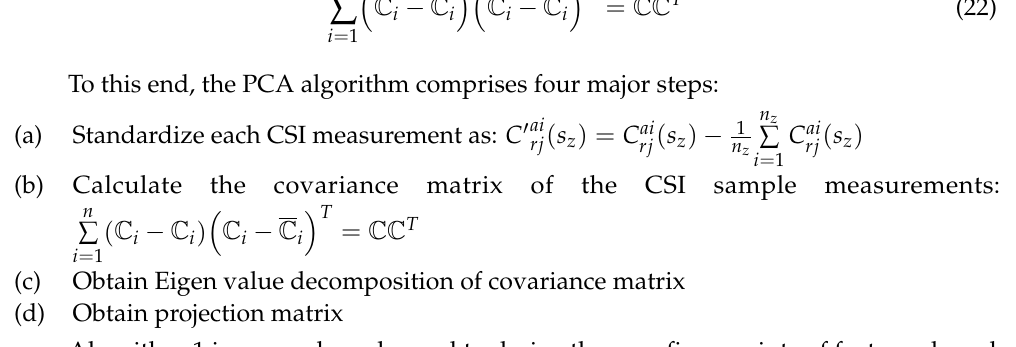
Algorithm 1 is a pseudo code used to derive the new fingerprints of features-based CSI using both data fusion techniques and principal component